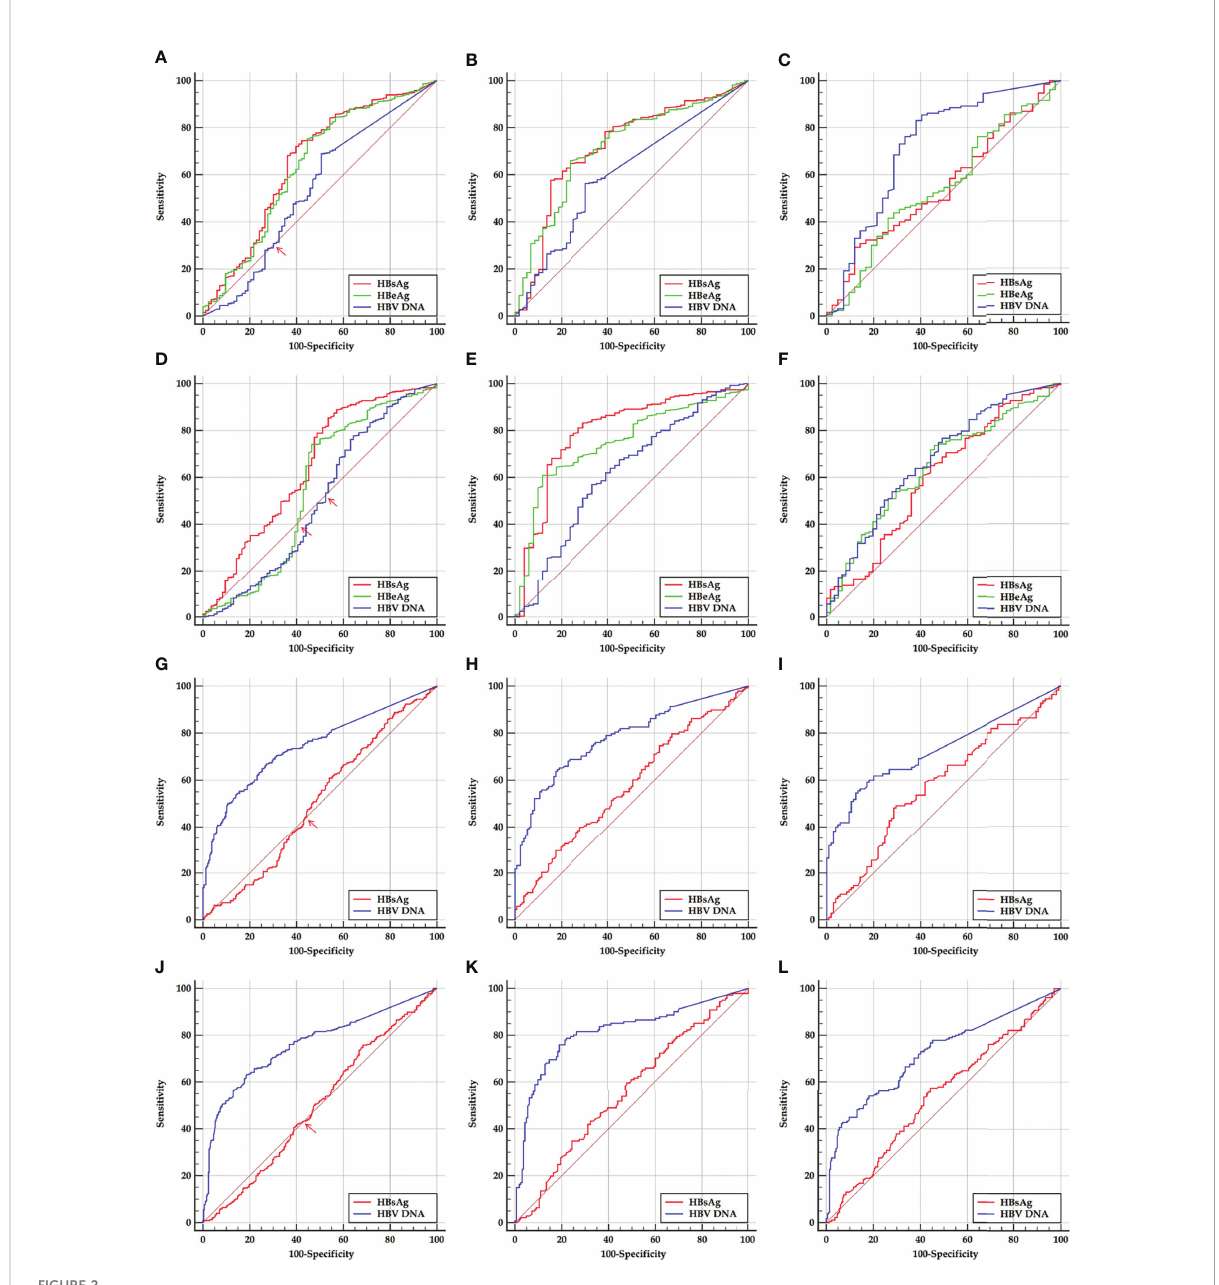
FIGURE 2 ROC curves of HBsAg, HBeAg, and HBV DNA in predicting SHA in HBeAg-positive and HBeAg-negative cohorts and their sub-cohorts. (A, D) Early and late HBeAg-positive cohorts. (B, E) Early and late HBeAg-positive sub-cohorts with PHVR. (C, F) Early and late HBeAg-positive sub- cohorts with PLVR. (G, J) Early and late HBeAg-negative cohort. (H, K) Early and late HBeAg-negative sub-cohorts with PHSE. (I, L) Early and late HBeAg-negative sub-cohorts with PLSE. ROC, receiver operating characteristic; HBsAg, hepatitis B surface antigen; HBeAg, hepatitis B e antigen; HBV DNA, hepatitis B virus DNA; PHVR, possibly high HBV replication; PLVR, possibly low HBV replication; PHSE, possibly high HBsAg expression; PLSE, possibly low HBsAg